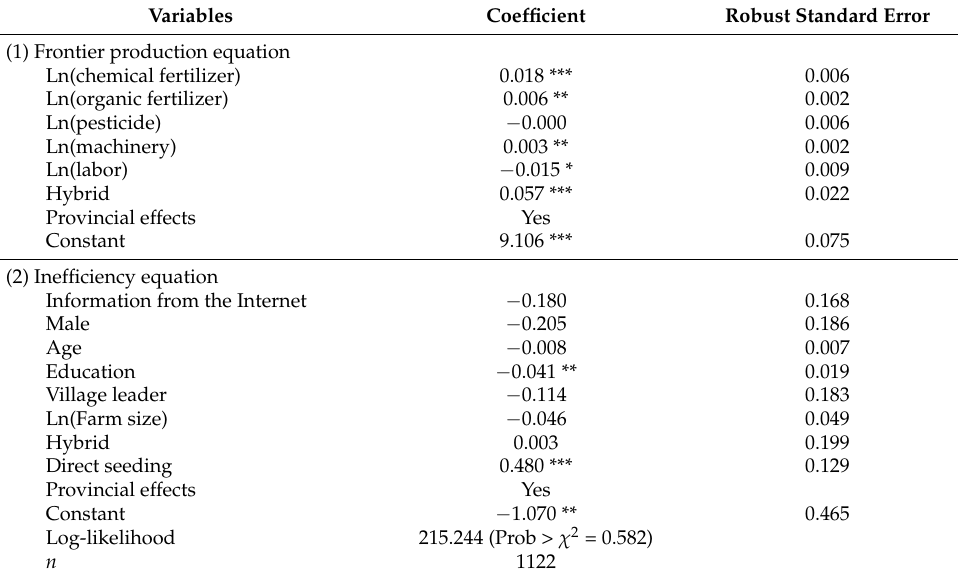
Table 3. Estimation results of the stochastic frontier production